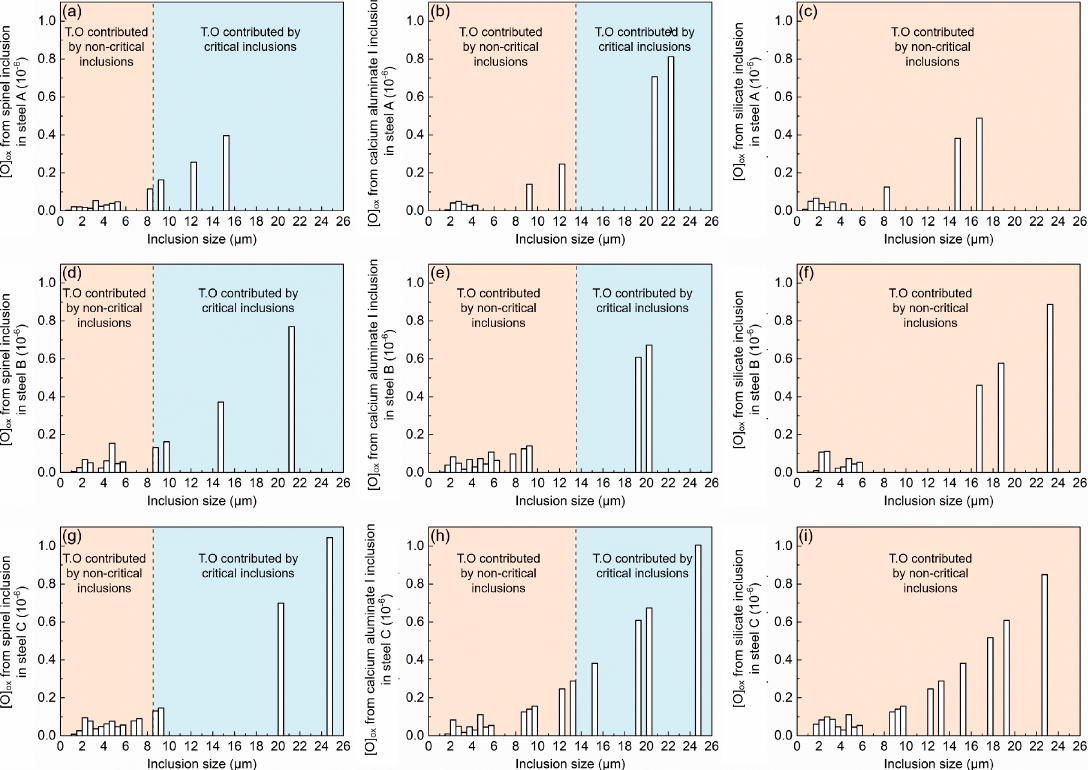
Figure 13. Histograms of [O] ox sorted by types: ( a ) Spinel inclusions in steel A; ( b ) calcium aluminate inclusions in steel A; ( c ) silicate inclusions in steel A; ( d ) spinel inclusions in steel B; ( e ) calcium aluminate inclusions in steel B; ( f ) silicate inclusions in steel B; ( g ) spinel inclusions in steel C; ( h ) calcium aluminate inclusions in steel C; ( i ) silicate inclusions in steel C.